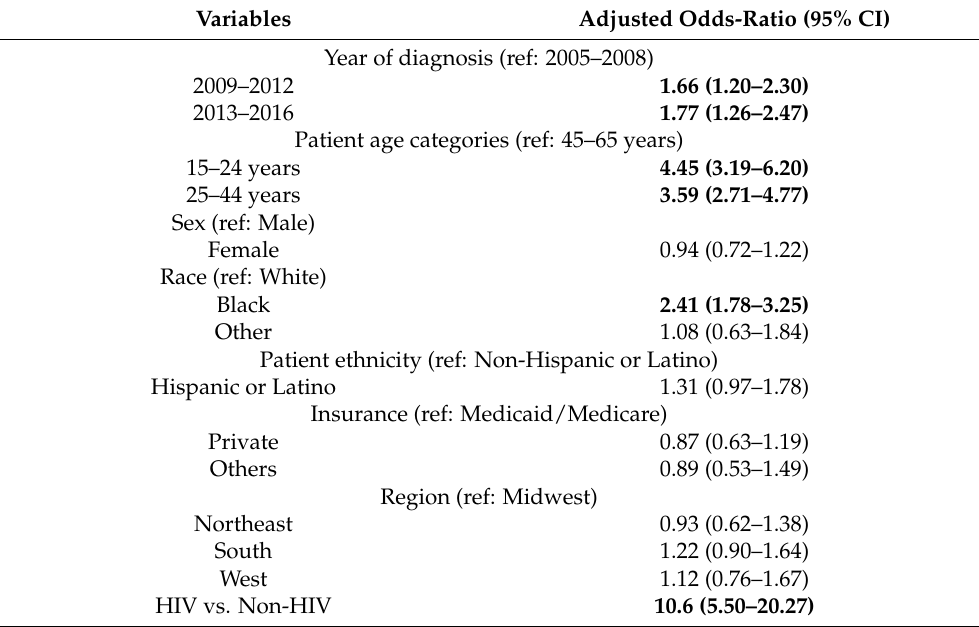
Table 3. Adjusted odds-ratios of risk factors and STI-related visits using data from NAMCS ( p =